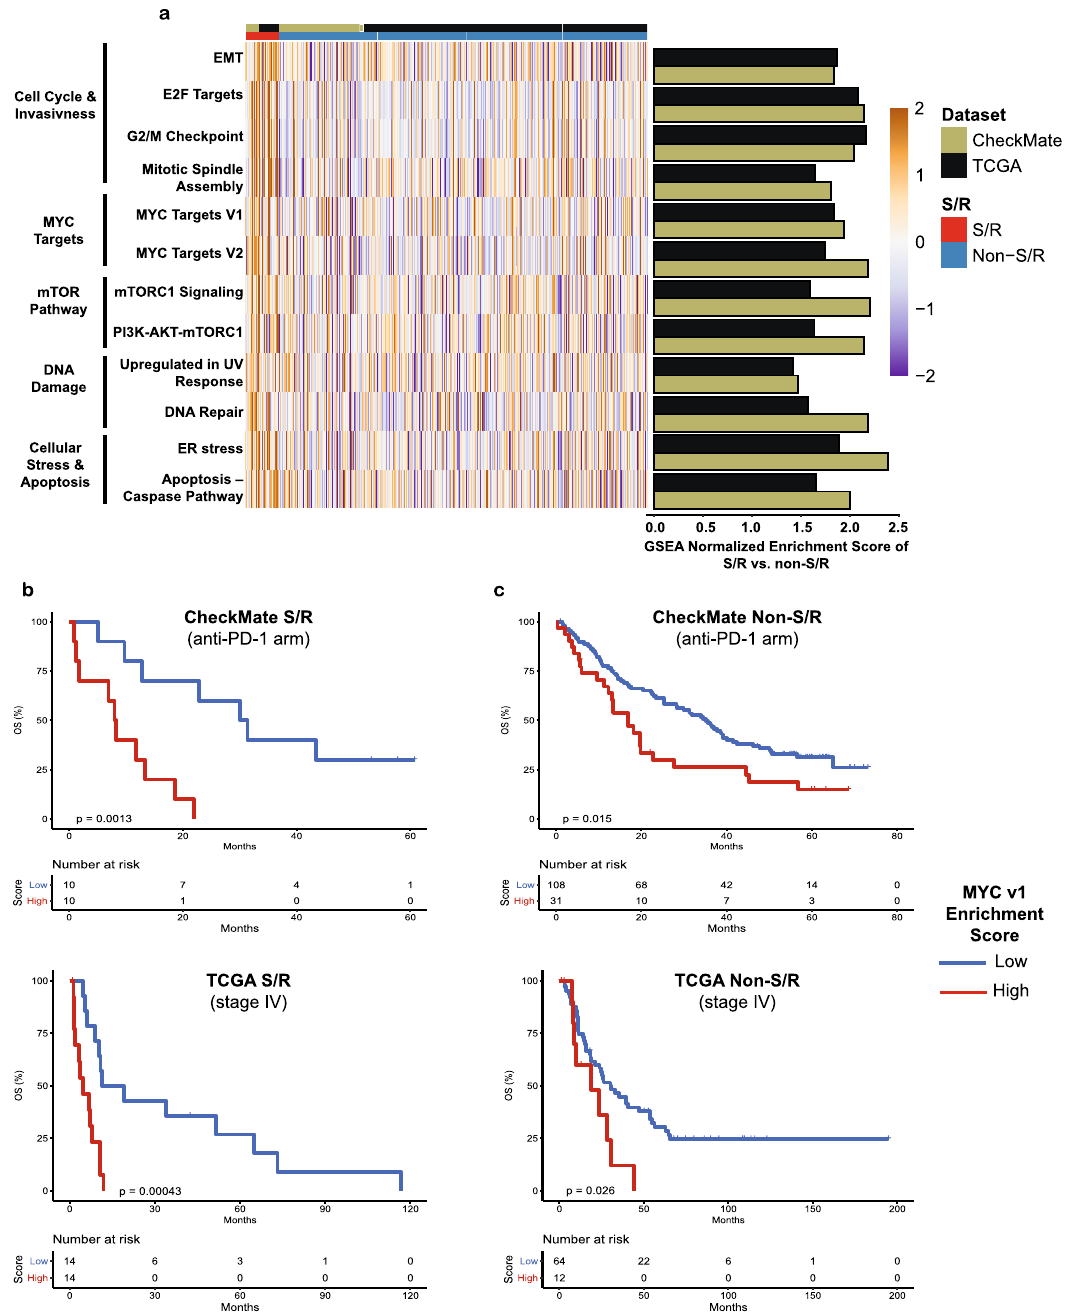
Fig. 2 Transcriptional pro fi ling of S/R RCC reveals the molecular correlates of its poor prognosis and identi fi es subsets of non-S/R tumors associated with a poor prognosis. a Heatmap and bar plots of the ssGSEA scores and GSEA normalized enrichment scores for the non-immune “ Hallmark ” gene sets that were found to be signi fi cantly enriched ( q < 0.25) in S/R compared to non-S/R RCC in both the TCGA and CheckMate cohorts independently. P -value calculated using a phenotype permutation-based two-sided test with 1000 permutations. Adjustments for multiple testing (50 “ Hallmark ” gene sets) were made using the false discovery rate (FDR) method. b Kaplan – Meier curves for OS by MYC v1 score within the S/R group of the CheckMate (anti-PD-1 arm) and TCGA (stage IV) cohorts; MYC v1 score dichotomized at the median. Log-rank test two-sided p-value reported without adjustment for multiple testing. c Kaplan – Meier curves for OS by MYC v1 score within the non-S/R group of the CheckMate (anti-PD-1 arm) and TCGA (stage IV) cohorts; MYC v1 score dichotomized at the median of the S/R group. Log-rank test two-sided p-value reported without adjustment for multiple testing. EMT: